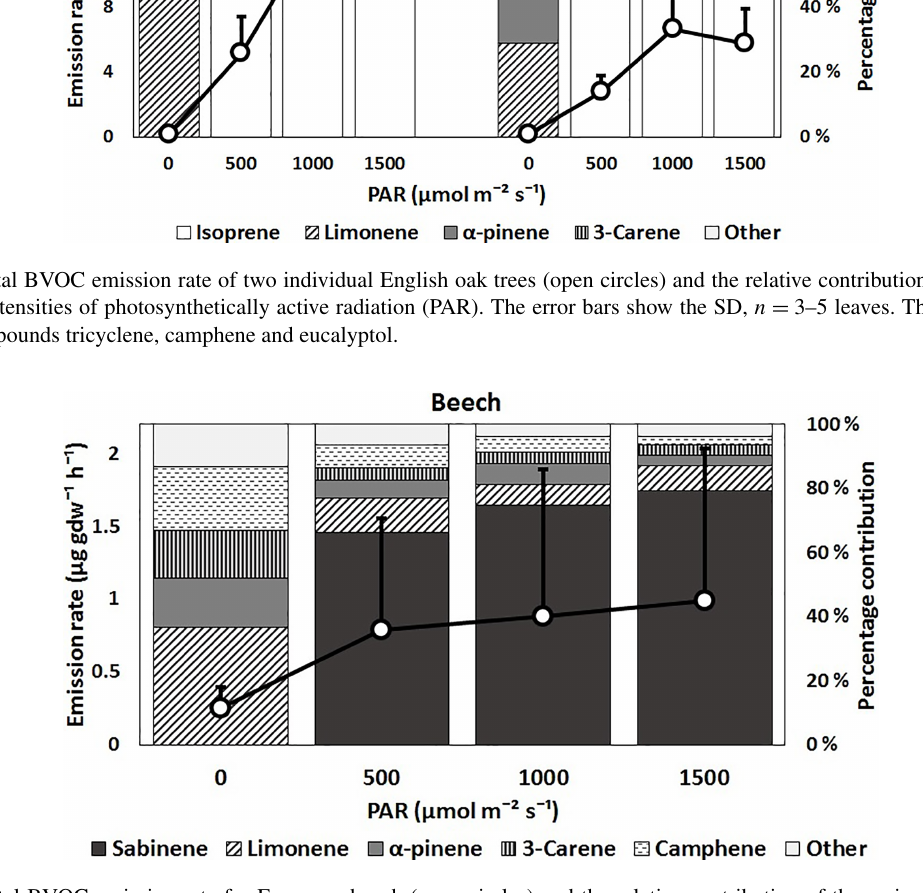
Figure 2. The total BVOC emission rate for European beech (open circles) and the relative contribution of the major compounds at four intensities of photosynthetically active radiation (PAR). The error bars show the SD, n = 4–6 leaves. The category “Other” contains the compounds tricyclene and